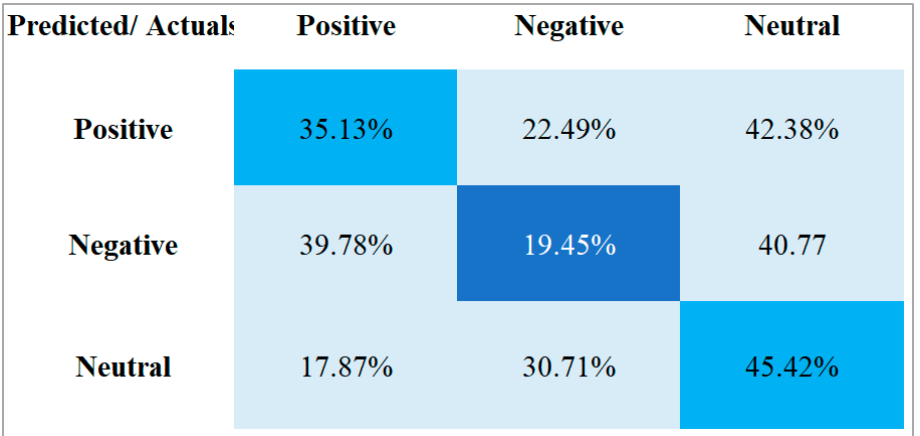
Figure 7. Confusion matrix of CNN-LSTM: Analysis de sentiments. Figure 8. Confusion matrix of CNN-LSTM: Analysis de